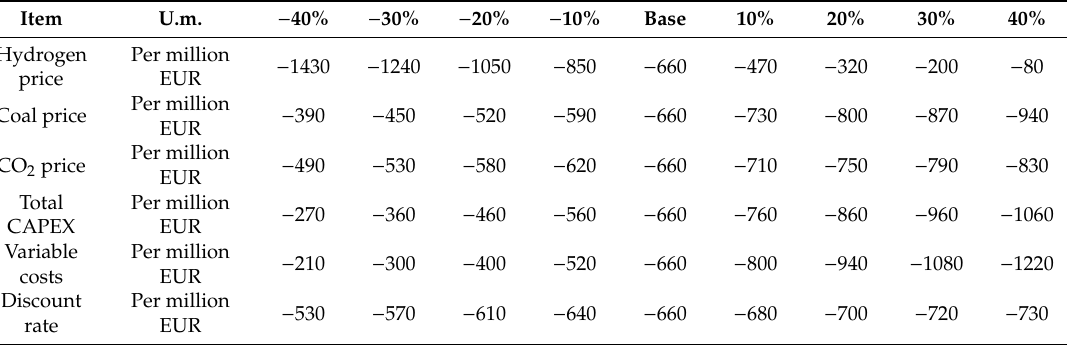
Figure 5. Sensitivity analysis for lignite gasification w/o CCS unit (L_H2_0). Source: own study.